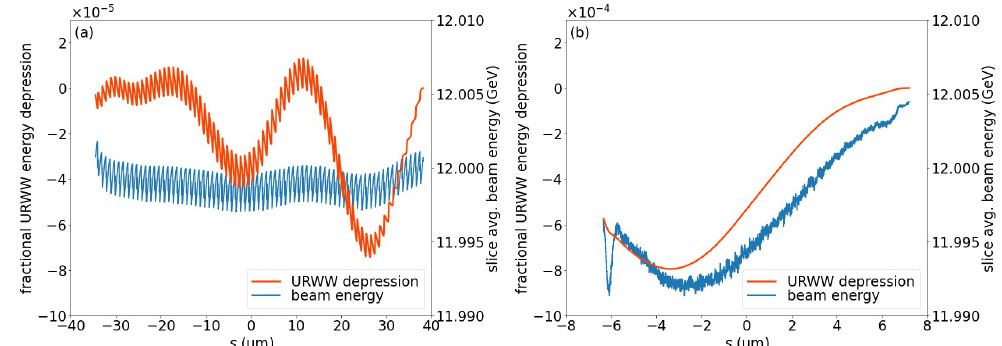
Figure 13. Comparison of the URWW effect on the electron beam ( a ) from lattice 1, processed with our LABC method and ( b ) with the conventional bulk compression method. In each plot, the distributions of the fractional URWW beam energy depression and of the predicted depressed beam energy distribution within the beam are provided. Note that the head of the beam is to the right of the